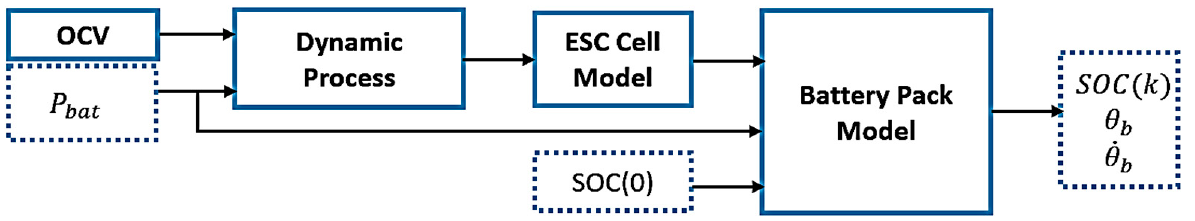
Figure 6. Schematic component of the battery pack electro-thermal model. The variables in dotted blocks are the inputs and outputs to the battery model.